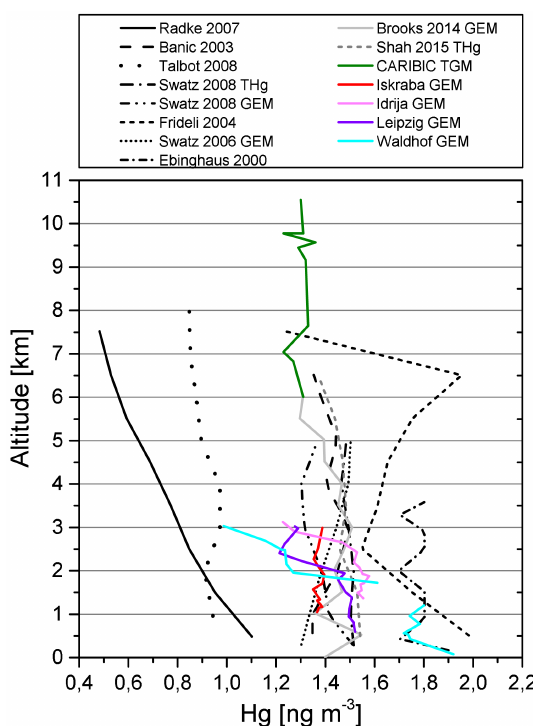
Figure 7. Comparison of known vertical gaseous mercury profiles (THg, TGM and GEM). Data plotted in black were taken from Swartzendruber et al. (2009). Data in grey represent the August measurement from Brooks et al. (2014) and the averaged data from Shah et al. (2016). Coloured data represent ETMEP-2 data (Figs. 3– 6). The Waldhof 1.47km flight leg average was removed from this plot, because it was probably measured inside a plume of polluted air (cf. discussion to Fig.